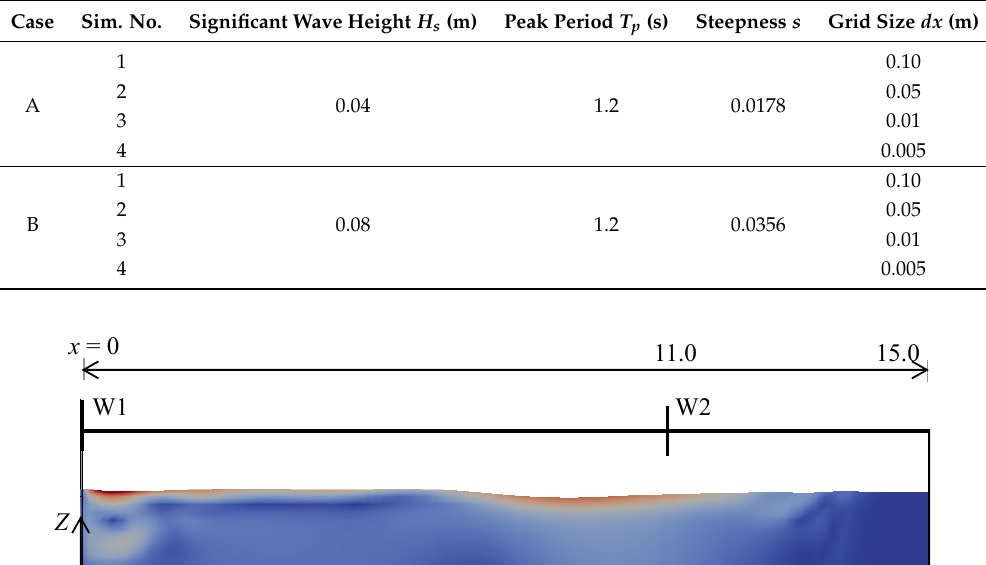
Table 1. List of simulation cases for theoretical inputs.